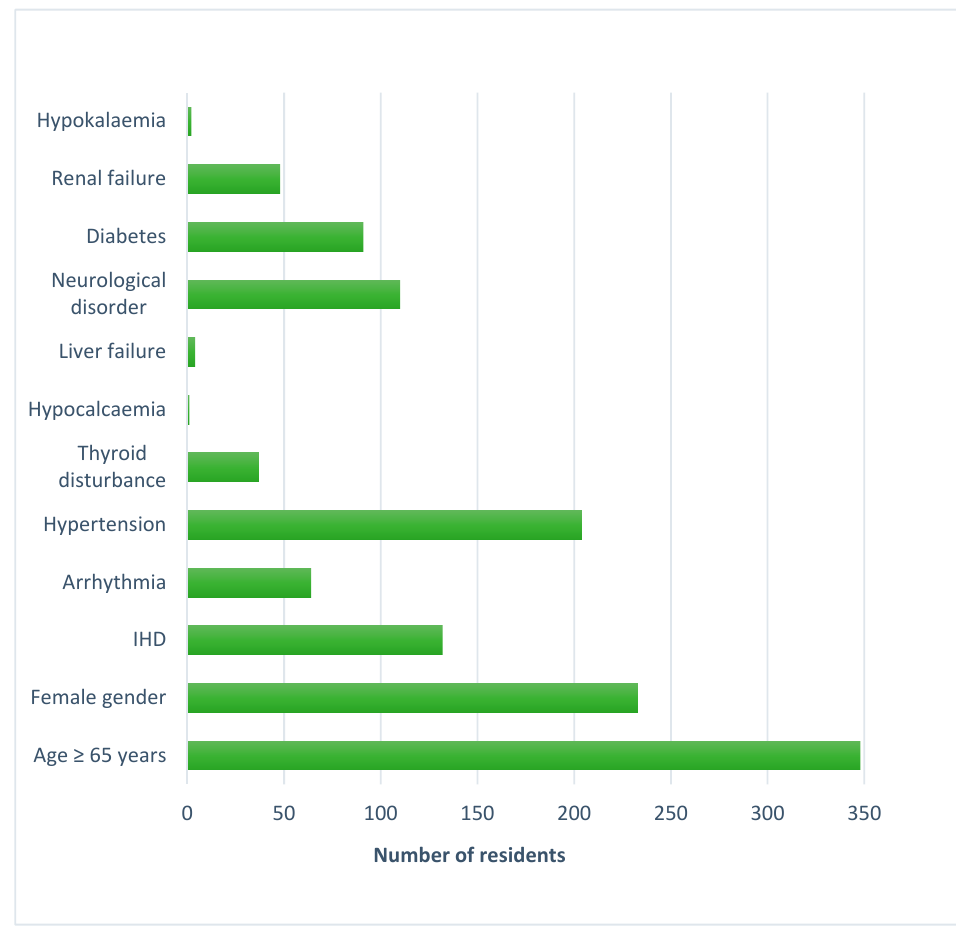
Figure 1. Prevalence of risk factors for drug-induced QT prolongation. IHD, Ischaemic heart disease .